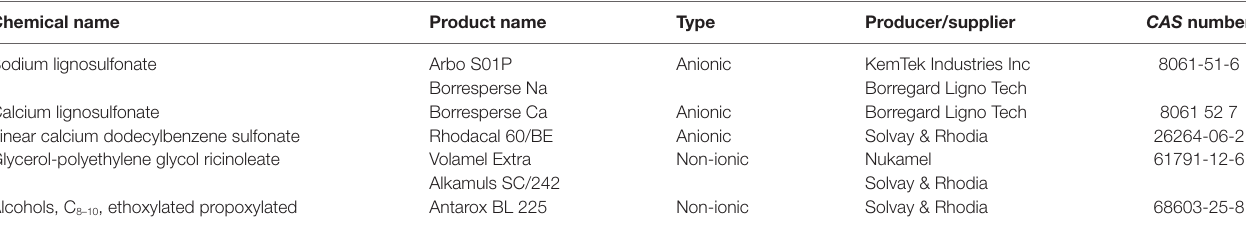
TABLe 3 | Various types of surfactants used in feed additives.